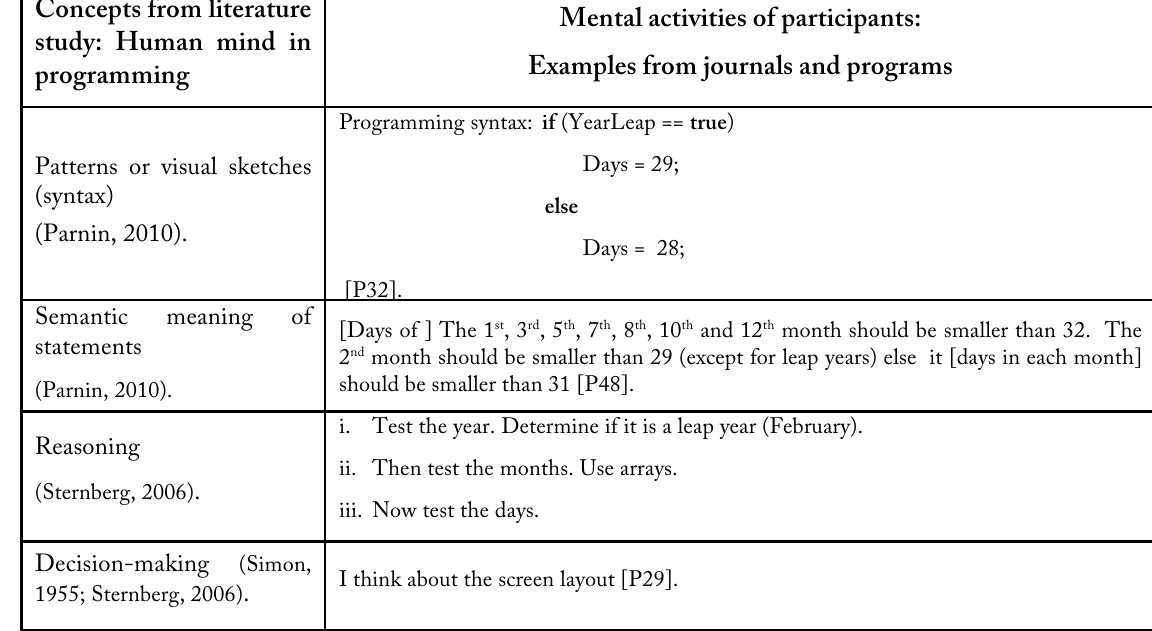
Table 1: The mental activities of successful students during programming Concepts from